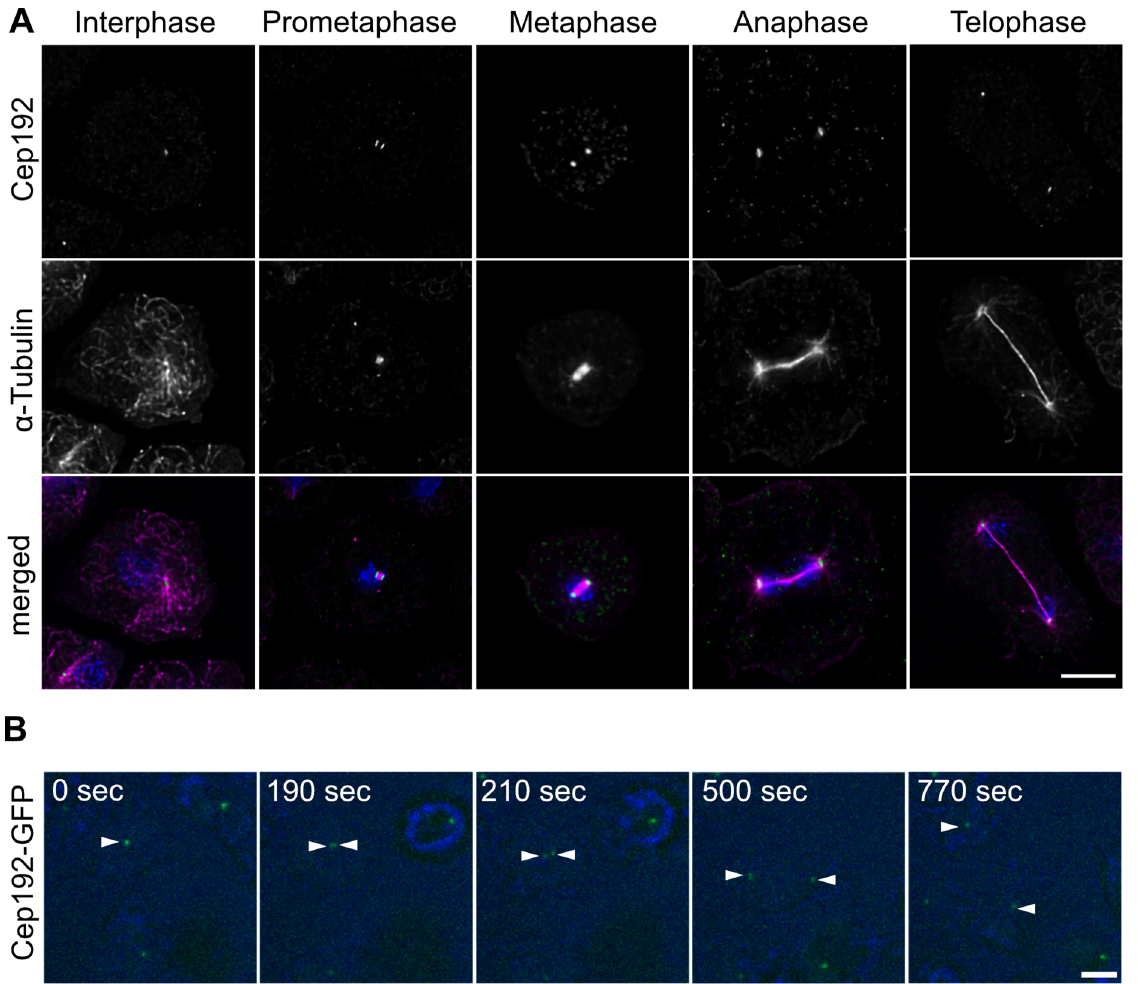
Figure 2. Cep192 is present at the mitotic spindle poles. ( A ) Immunofluorescence microscopy of AX2 cells in interphase and indicated mitotic stages, stained with anti-Cep192 and anti- α -Tubulin. Secondary antibodies were anti-rabbit-AlexaFluor-488 and anti-rat-AlexaFluor-568, cells were fixed with methanol, DNA stained with DAPI. ( B ) Cep192-GFP is present during the splitting of the mitotic centrosome. Selected time points from video S2 are displayed. Cells were viewed under agar overlay. Bars = 5 µm.